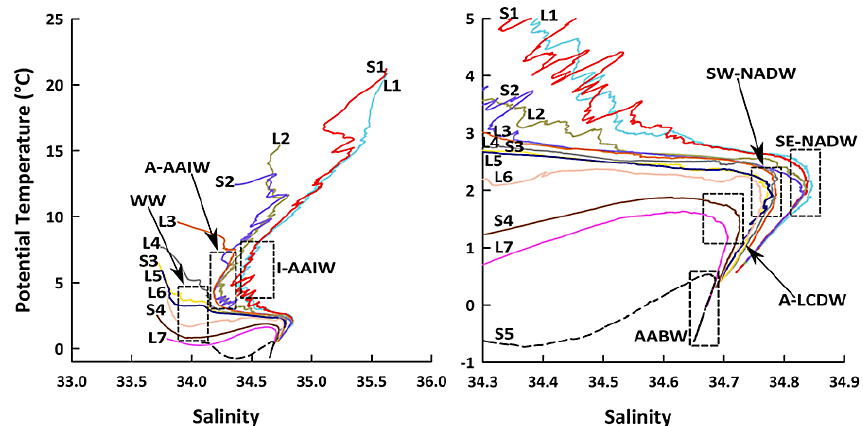
Fig. 2. Diagrams of potential temperature ( ◦ C) versus salinity in the whole water column (left panel) and in deep waters (right panel) at the stations sampled for trace metals determination (CTD data and validation from Branellec et al., 2010; Kermabon and Arhan,